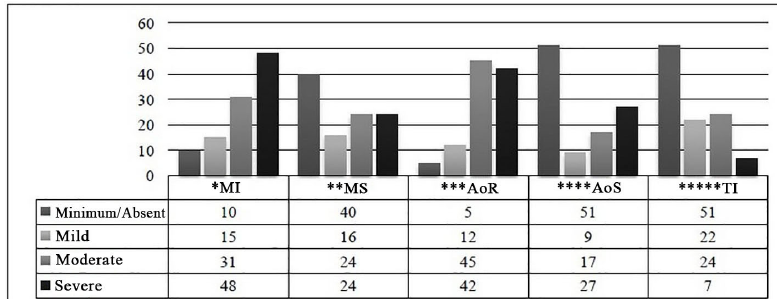
Fig. 1 - Distribution of studied patients by valvular’s injury degree of. Salvador 2007-2011.